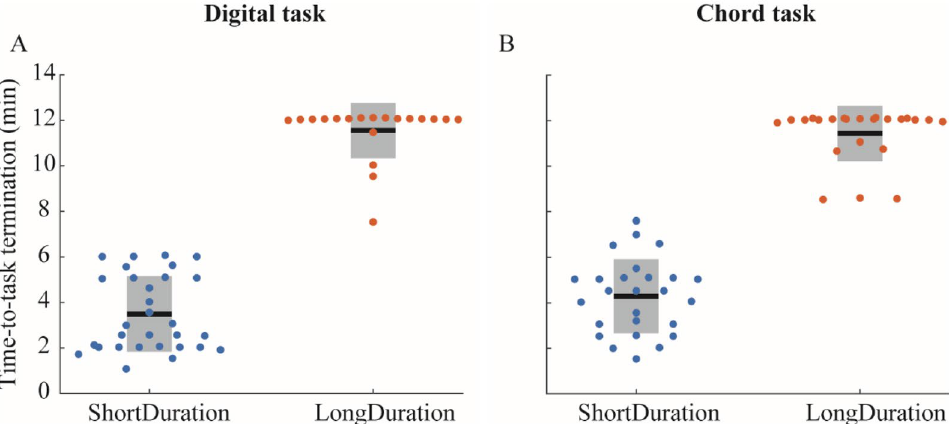
Figure 1. Time-to-task termination for ( A ) the Digital task and ( B ) the Chord task. Black horizontal lines represent the mean duration for each group, grey boxes represent the standard deviation, and dots represent each participants’